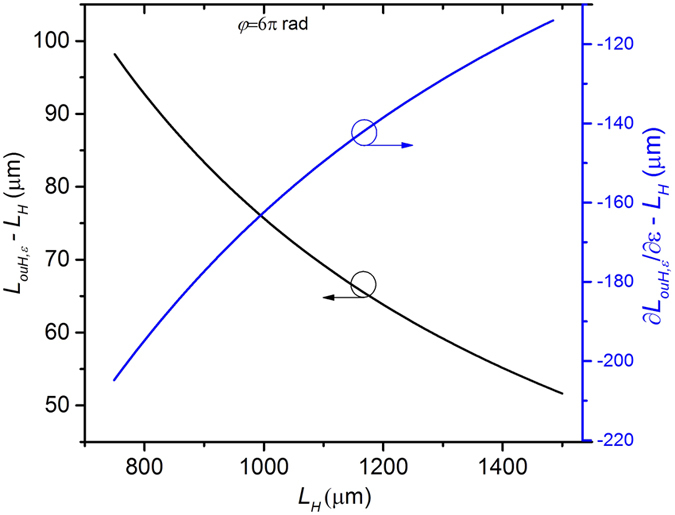
Variations of (LouH,ε − LH) and (∂LouH,ε/∂ε − LH) with increasing LH when φ = 6π rad.